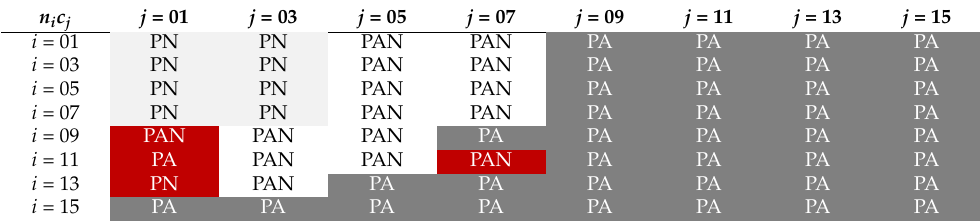
Table 8. Classifications of respondents’ perceived asymmetry